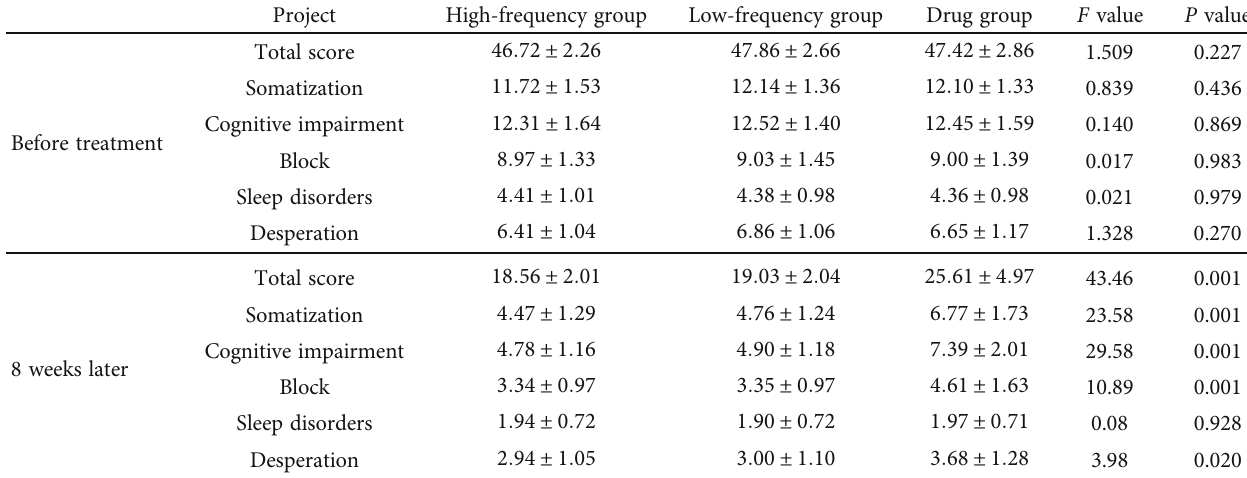
Table 5: Score analysis of Hamilton Depression Scale in three groups ( (cid:1) x ± s ). Project